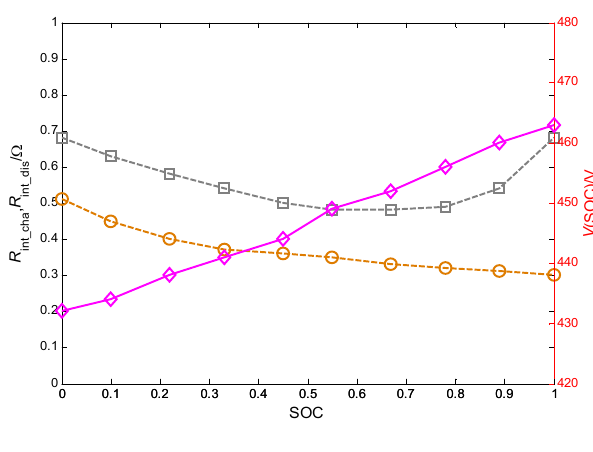
Figure 4. Parameters of V oc and R int